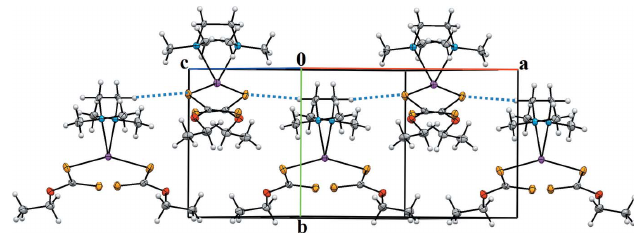
Figure 2 Two-dimensional wave-like structure extending in the ab plane formed by